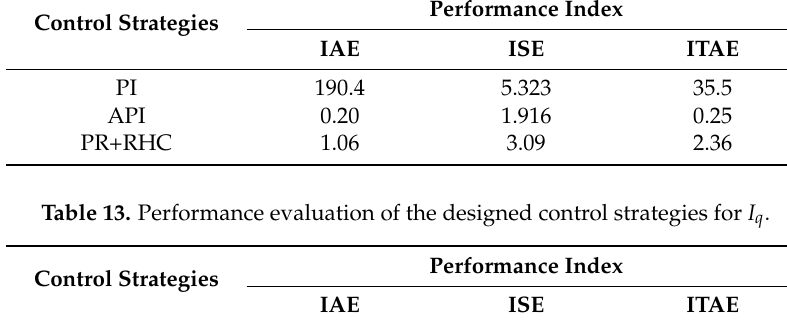
Table 12. Performance evaluation of the designed control strategies for I d .